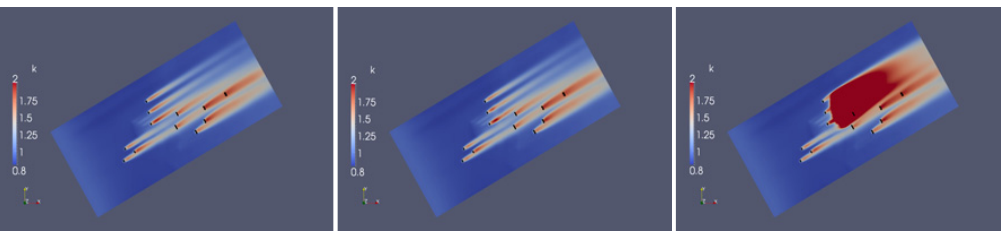
Figure 6. Turbulent kinetic energy (in m 2 s − 2 ) at a height of 65 m for case A (left), B (center) and C (right). Incoming wind from the WSW